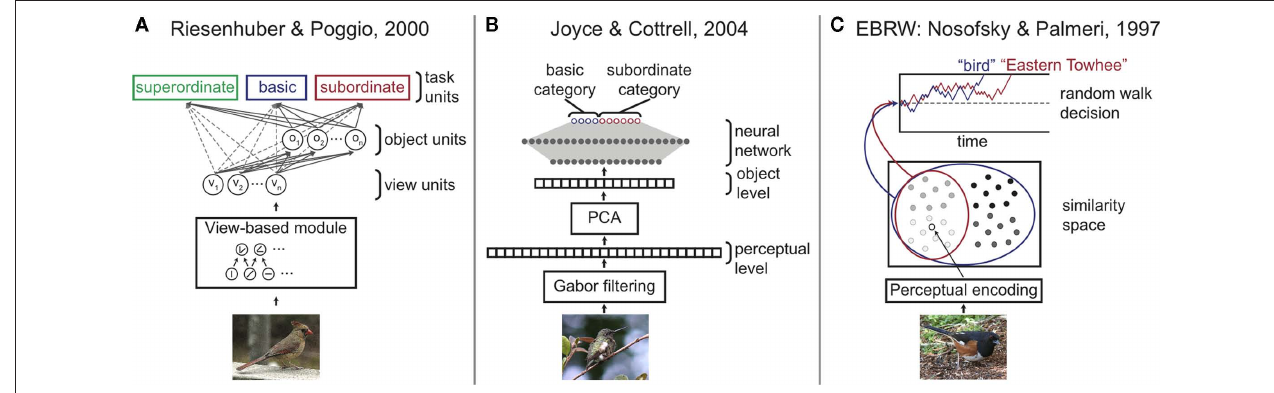
Figure 3 | illustration of three computational models of visual object categorization. (A) Riesenhuber and Poggio’s (2000) model assumes a hierarchy of visual processing that begins with encoding of low-level features and feature conjunctions, moves on to view-based representations and object representations, which are then mapped to task units representing different levels of categorization. (B) Cottrell and colleagues’ model of object recognition proposes a hierarchy of visual processing of Gabor filtering, principal components analysis (PCA), and then a neural network mapping PCA